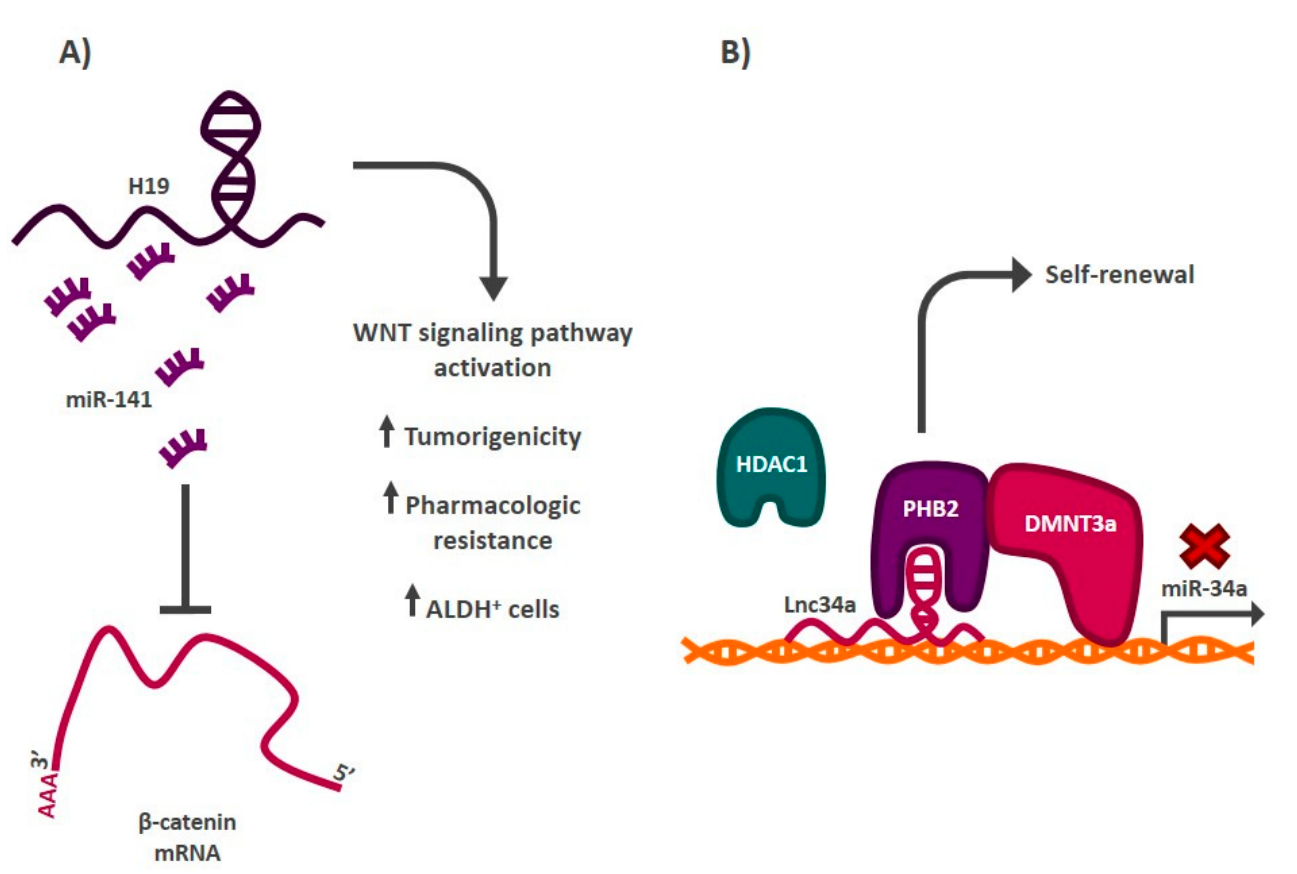
Figure 4. Role of lncRNAs in the regulation of the stem phenotype in colorectal cancer. ( A ) lncRNA H19 functions as a sponge by sequestering miR-141, a negative regulator of β -catenin mRNA, generating the activation of the WNT signaling pathway and increasing the proportion of ALDH cancer stem cells + , among other features. ( B ) Lnc34a recruits chromatin remodelers to the promoter region of miRNA-34a, blocking its expression. This allows cancer stem cells to self-renew.